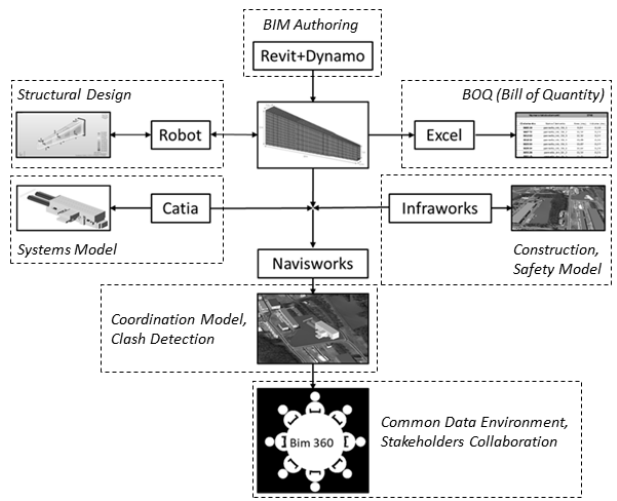
Figure 4. Flowchart of the proposed BIM process.